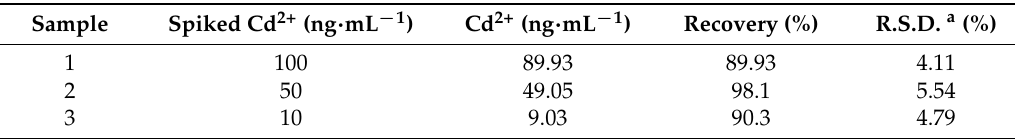
Table 2. Cd 2+ concentrations in real lake water samples ( n =